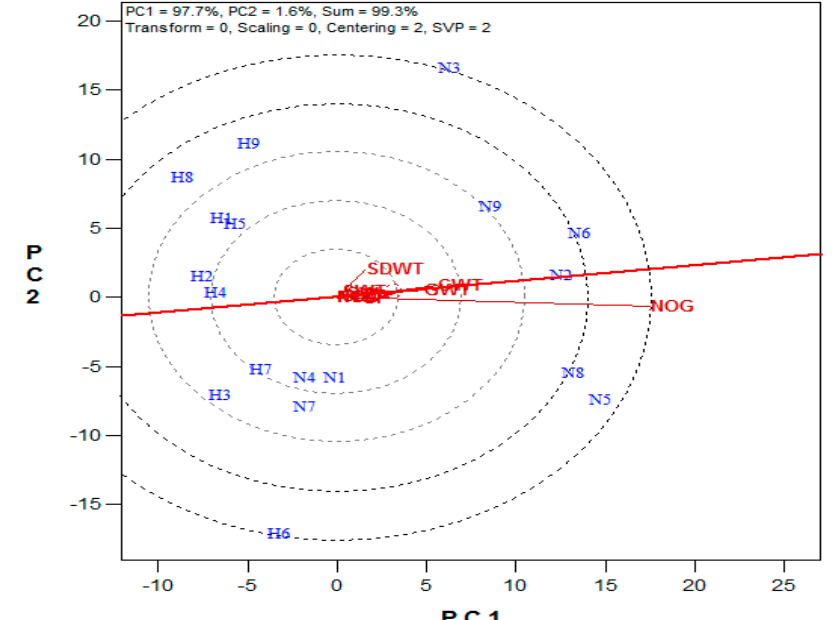
Figure 5. The discriminating and representative abilities of the maize yield attributes. (N1 =